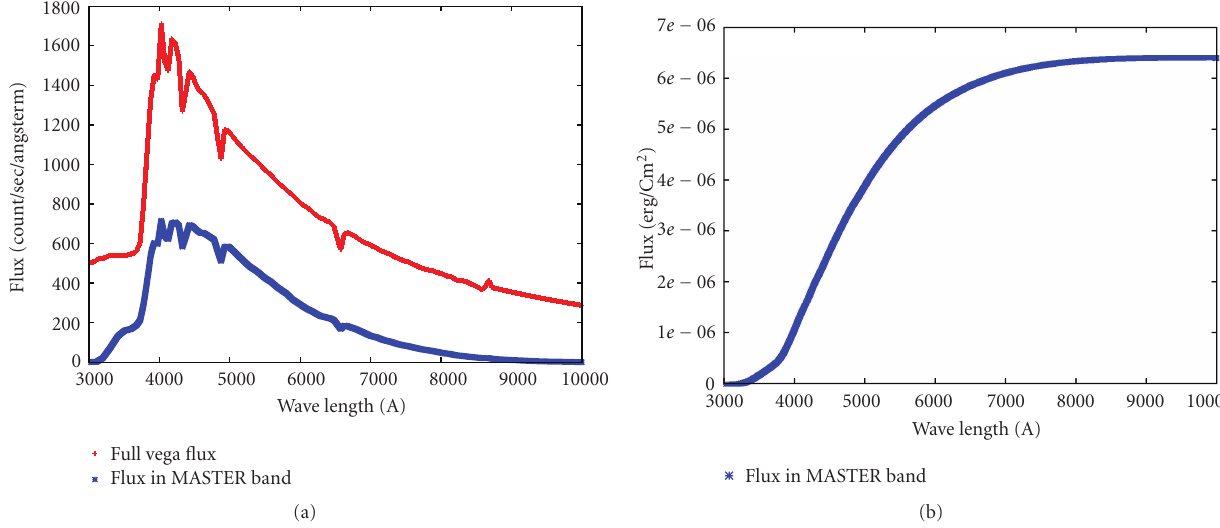
Figure 13: The spectrum of Vega and the same spectrum as observed after passing through the MASTER-VWF band (a). The cumulative curve of this spectrum in power units